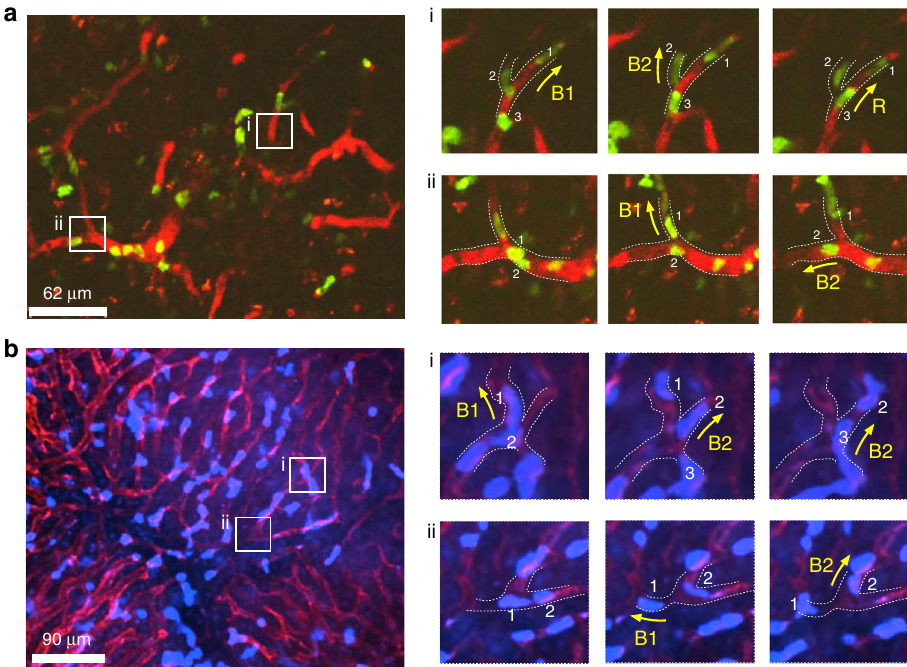
Fig. 1 Consecutive decision making of neutrophil squads at capillary bifurcations in vivo. a Multiphoton-microscopic imaging of neutrophils moving in lymph node capillaries following the infection with S. aureus . b Multiphoton-microscopic imaging of neutrophils moving in liver capillary following local tissue damage. Panel i and ii are the zoom-in time-lapse images at the locations indicated with the white square. B1 and B2 represents branch 1 and branch 2. The yellow arrows indicate the migration direction of the neutrophils. The white dashed lines highlight the outline of the capillary